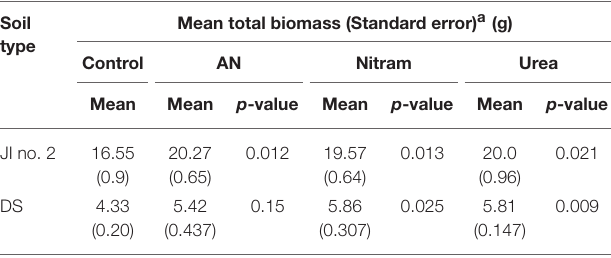
TABLE 2 | Mean final biomass and significance from controls at 95% of turfs grown in JI no. 2 and degraded soil (DS).